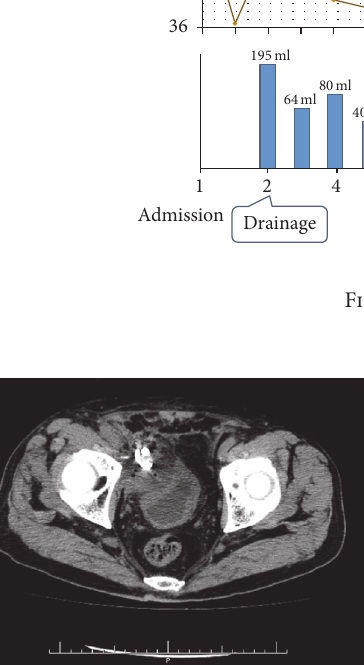
Figure 3: CT scan shows reduction of the lymphocele few days after